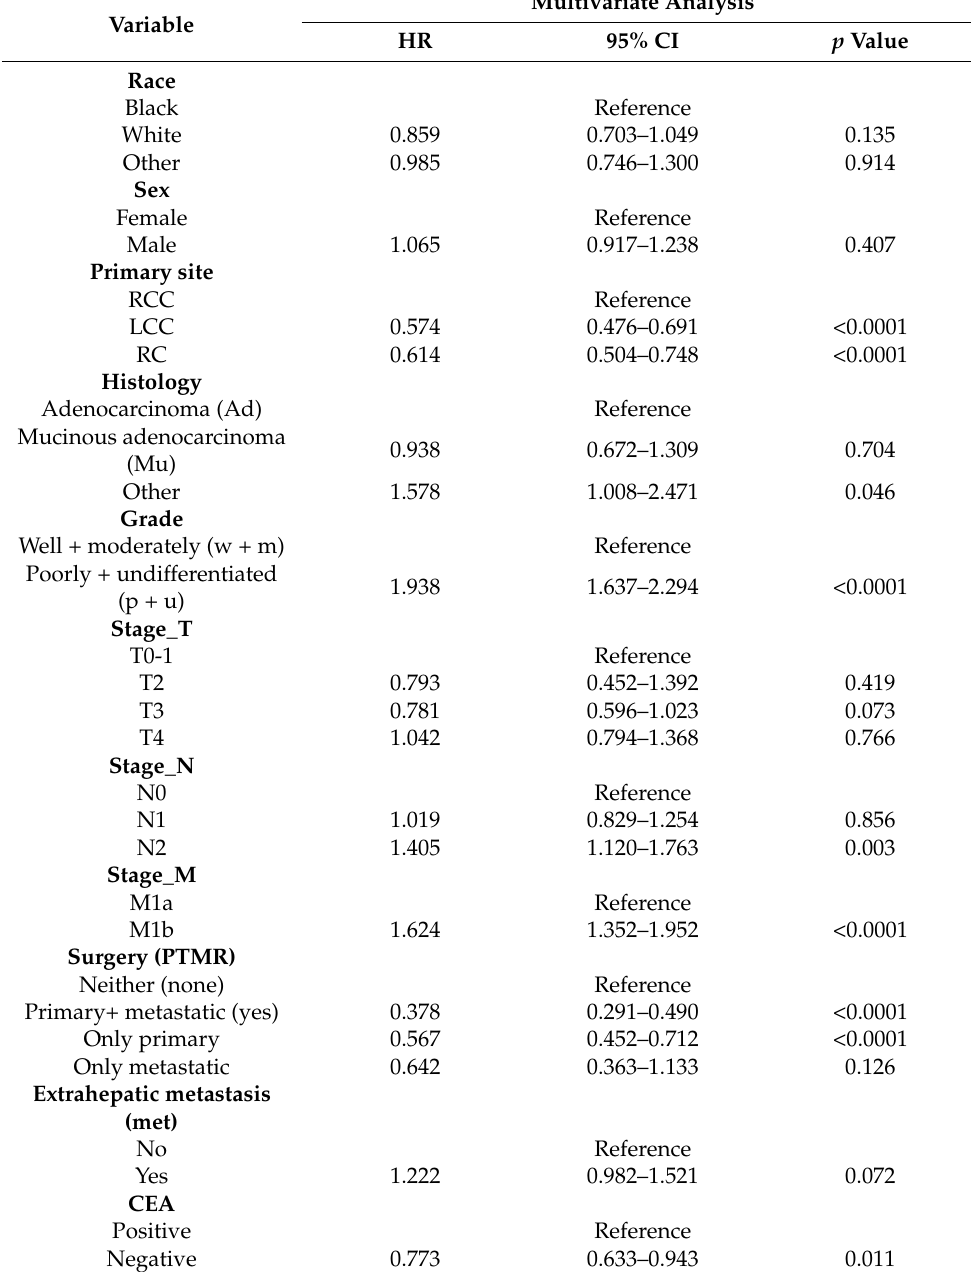
Table 2. Multivariable analyses of Cancer-Specific Survival in the training